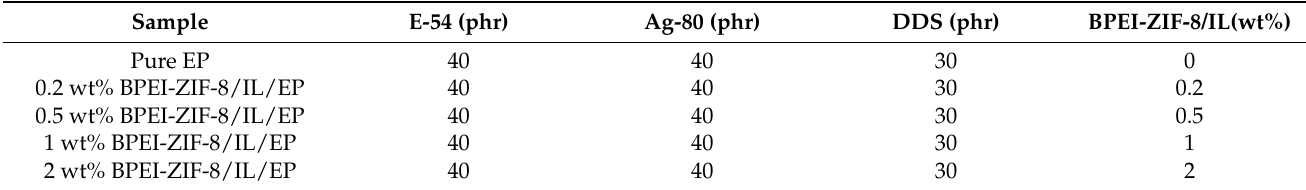
Table 1. Formulations of EP composites with BPEI-ZIF-8/IL.